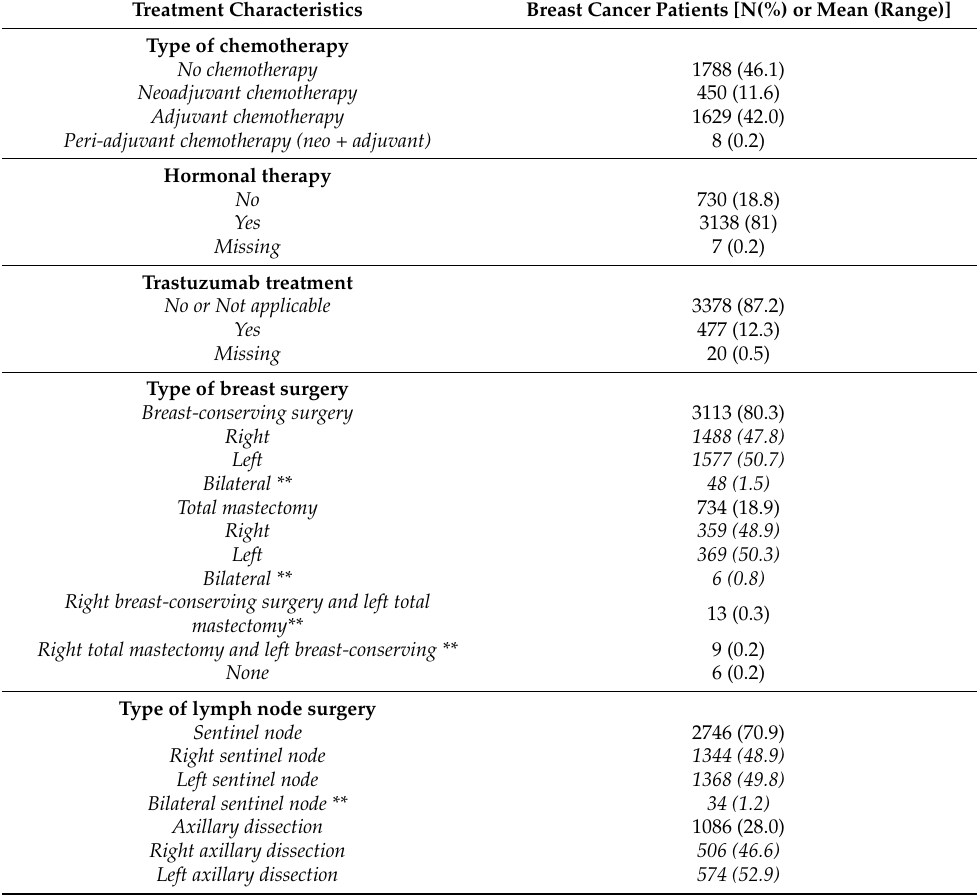
Table 2. Characteristics of the CANTO-RT